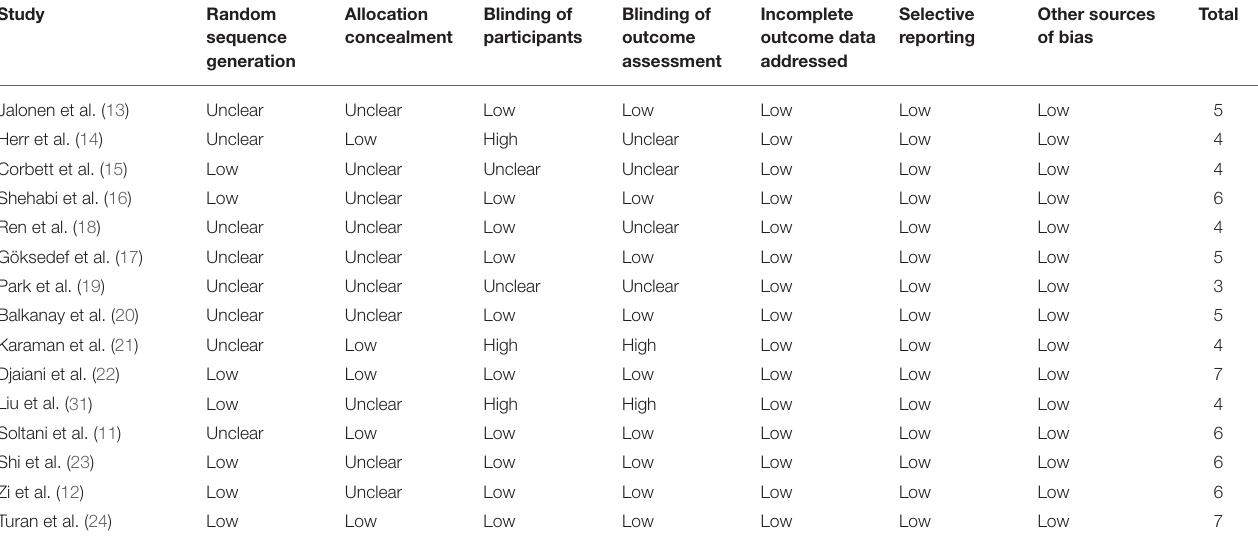
TABLE 2 | Details of study quality evaluation via the Cochrane’s Risk of Bias